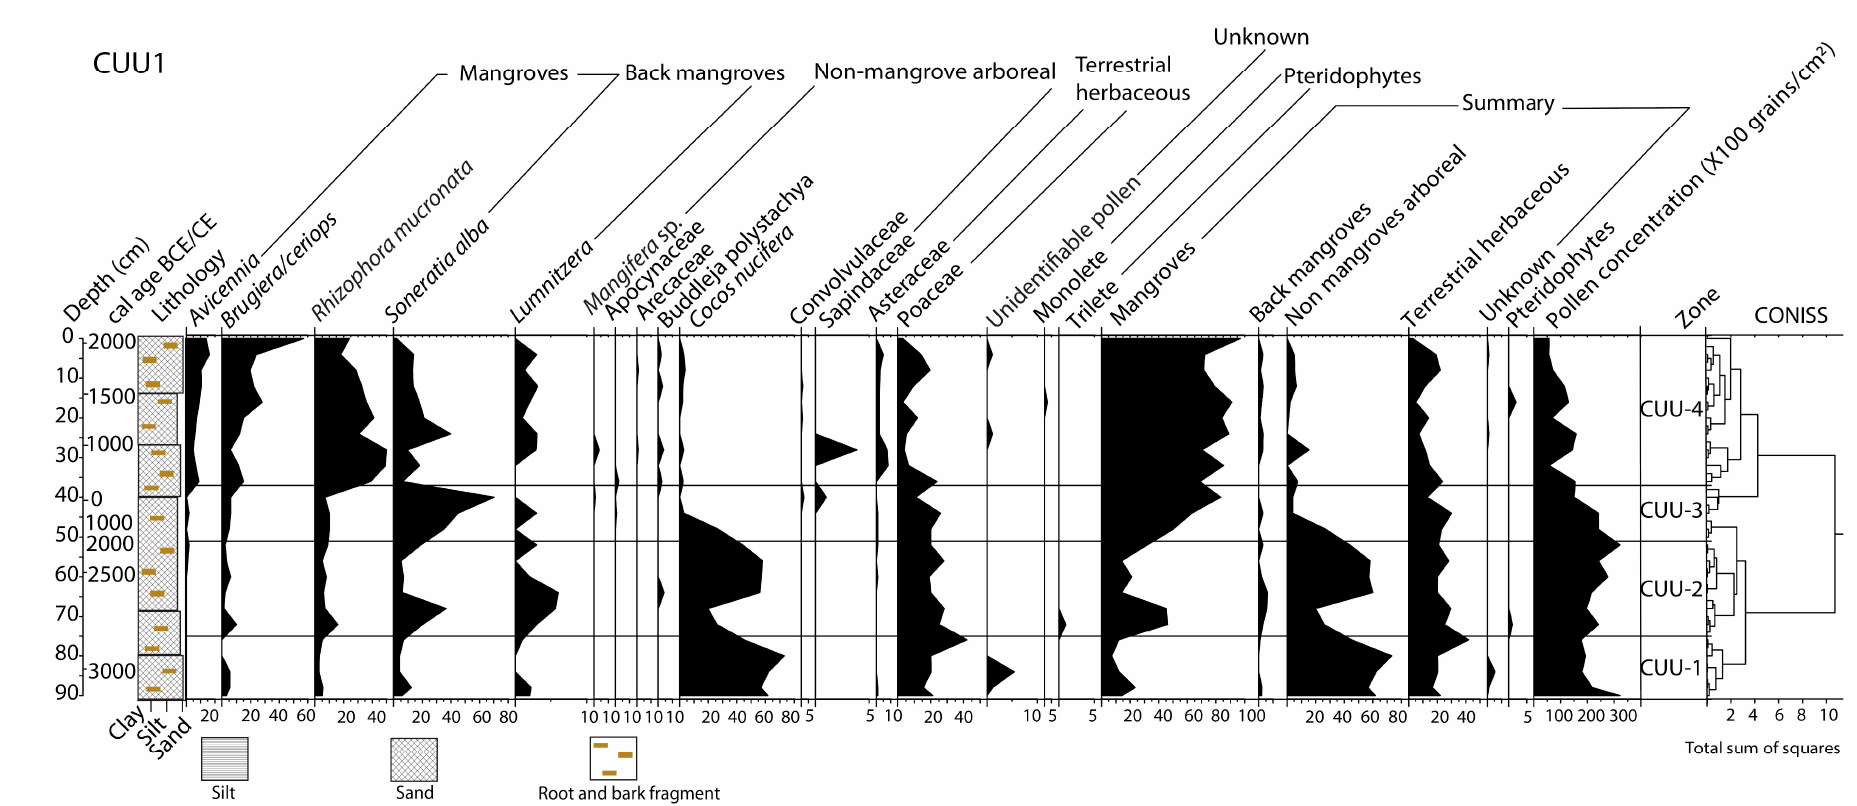
Figure 6. Pollen percentage diagram of CUU1 core.